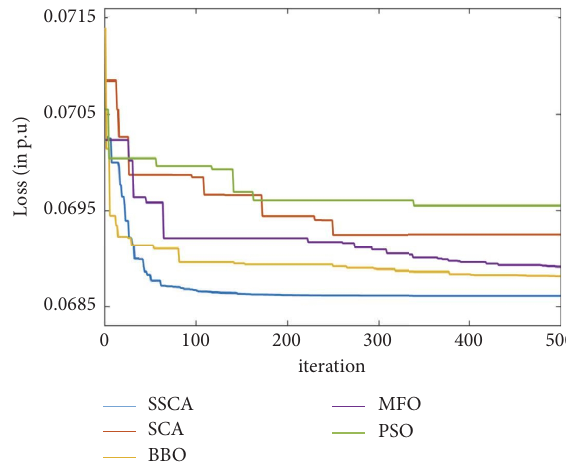
Figure 2: Loss variation in the IEEE-30 bus system at 100% loading.